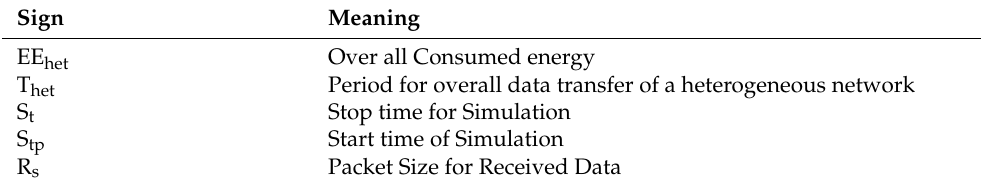
Table 3. Signs Used in Equations and their Meaning.